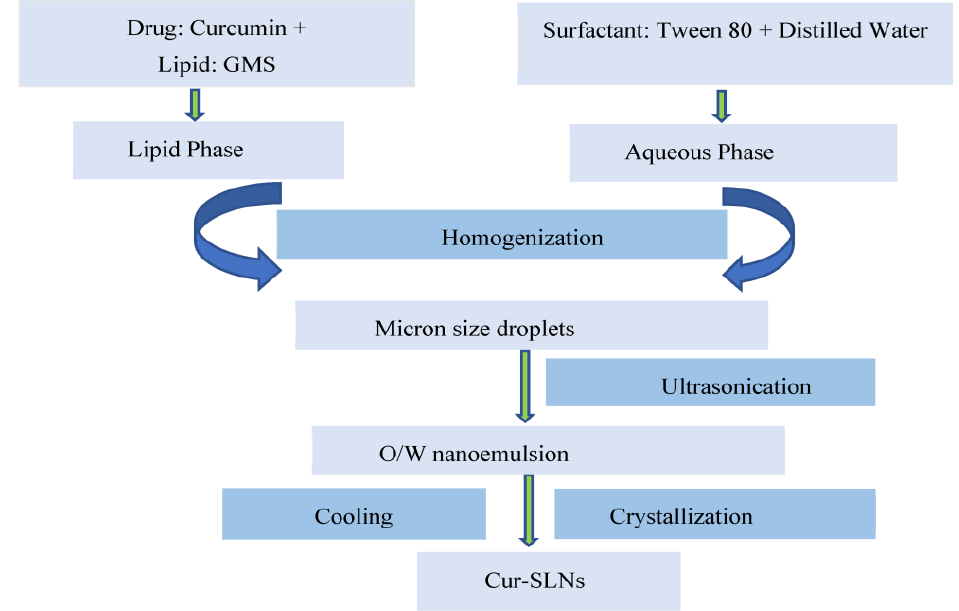
Figure 1. Schematic representation for the preparation of curcumin loaded solid lipid nanoparticles (Cur-SLNs).